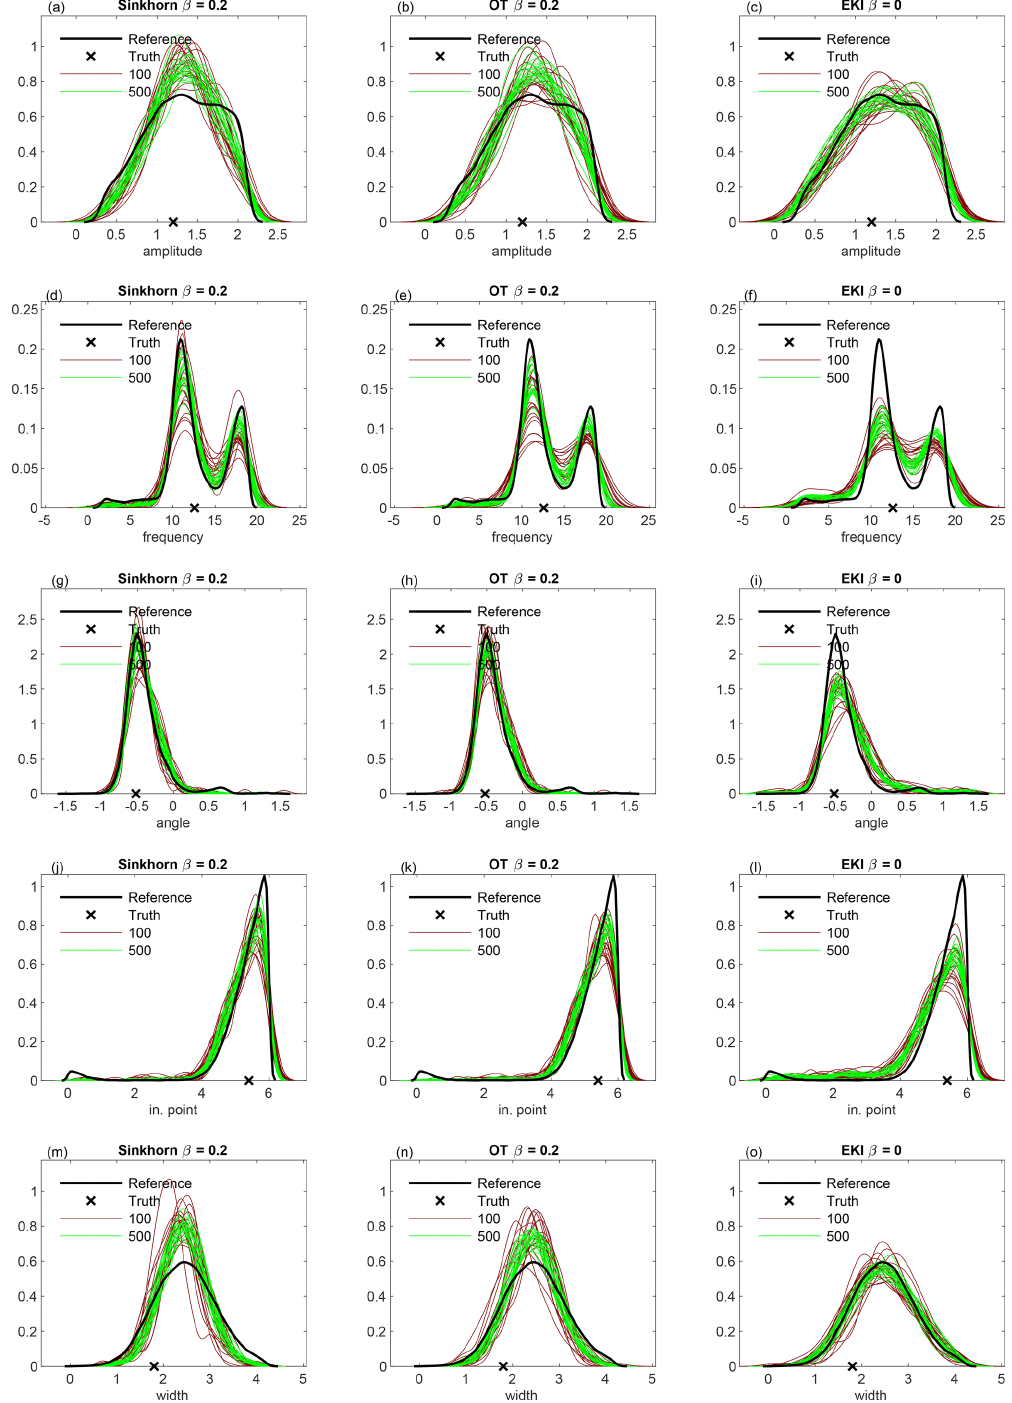
Figure 6. Posteriors of geometrical parameters for F2 inference: amplitude (a–c) , frequency (d–f) , angle (g–i) , initial point (j–l) and width (m–o) . On the left is the TESPF(0.2), in the middle the TETPF(0.2) and on the right the EKI. In black is the reference, in red 20 simulations of ensemble size M = 100 and in green 20 simulations of ensemble size M = 500. The true parameters are shown by black